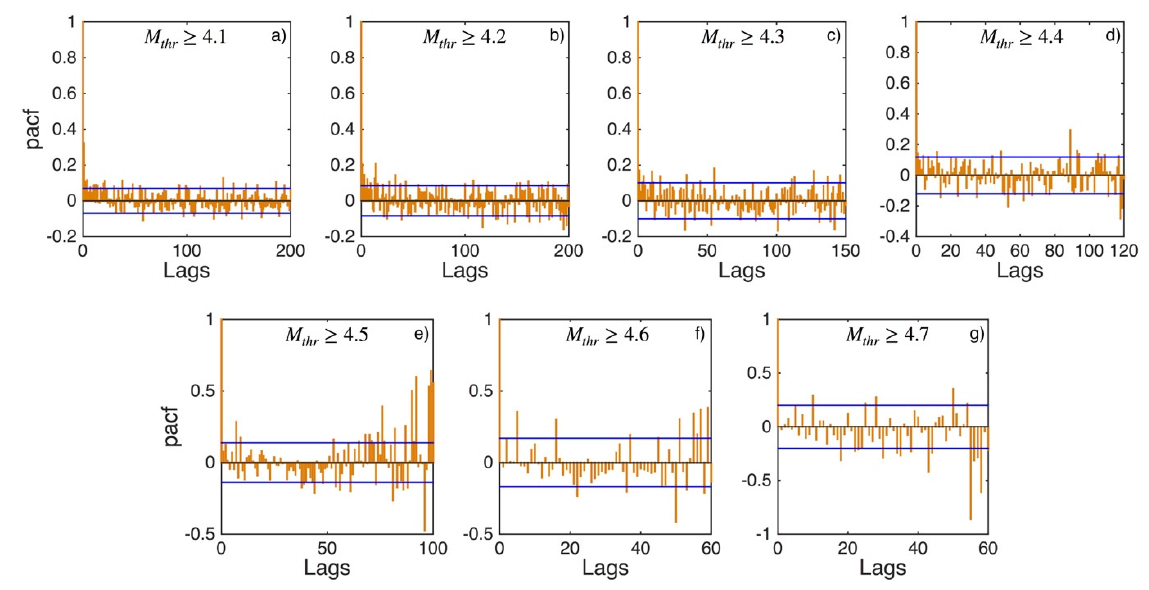
Figure A13. ACF values (red stems) and their 95% confidence intervals (blue lines) for Southwest Aegean Sea and Peloponnese (sub − area 6) for magnitude thresholds ( M thr ) varying from 4.1 to 4.7 (subplots a – g ).